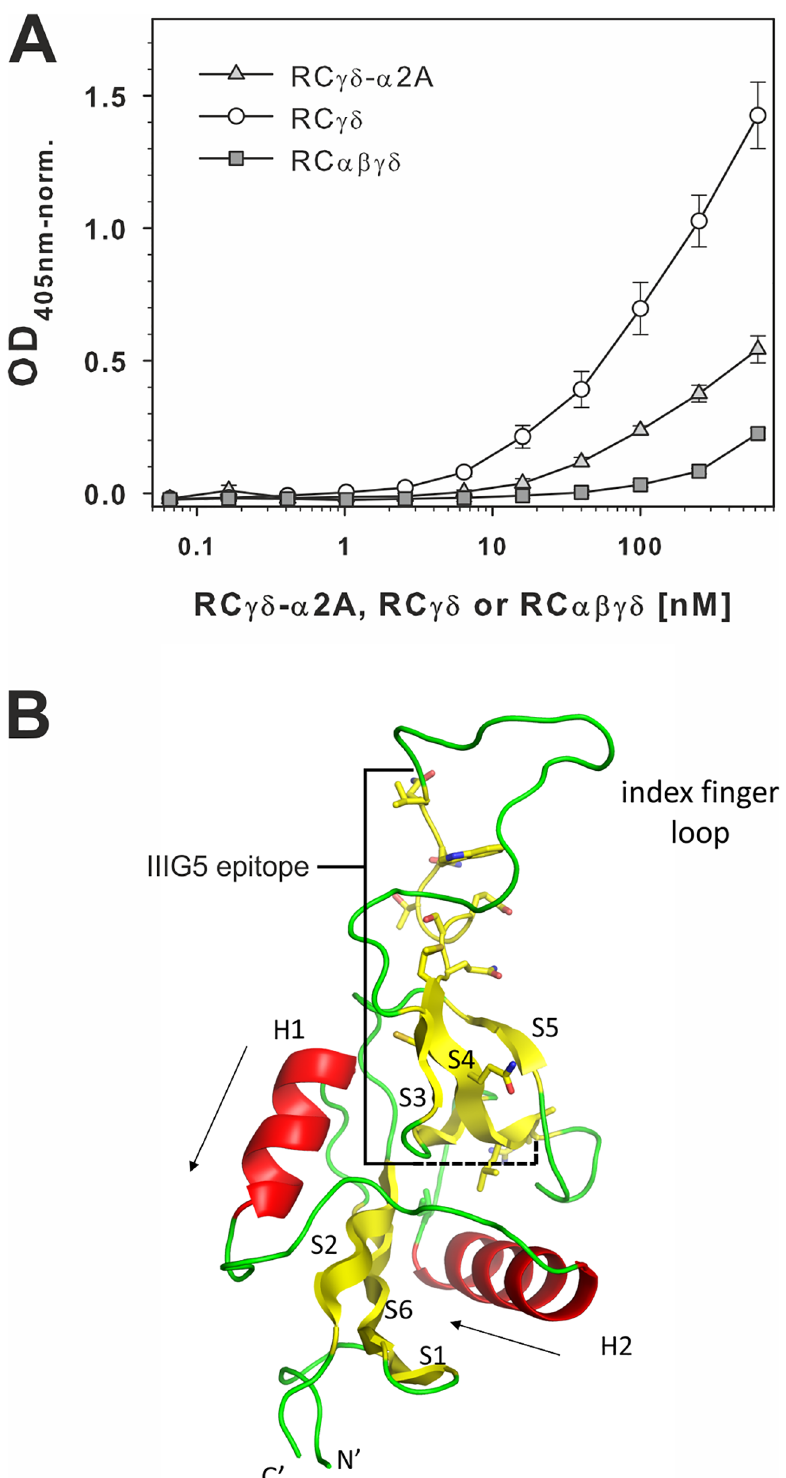
Fig 4. The monoclonal antibody IIIG5 recognizes its epitope within the RC γ subunit in the RC γδ - α 2A complex but not in the tetrameric RC αβγδ . ( A ) The monoclonal antibody IIIG5 recognizedan epitopeof the RC γ subunit, which is fully accessible in the RC γδ subunit( (cid:14) ), partiallyaccessiblein the RC γδ - α 2A complex